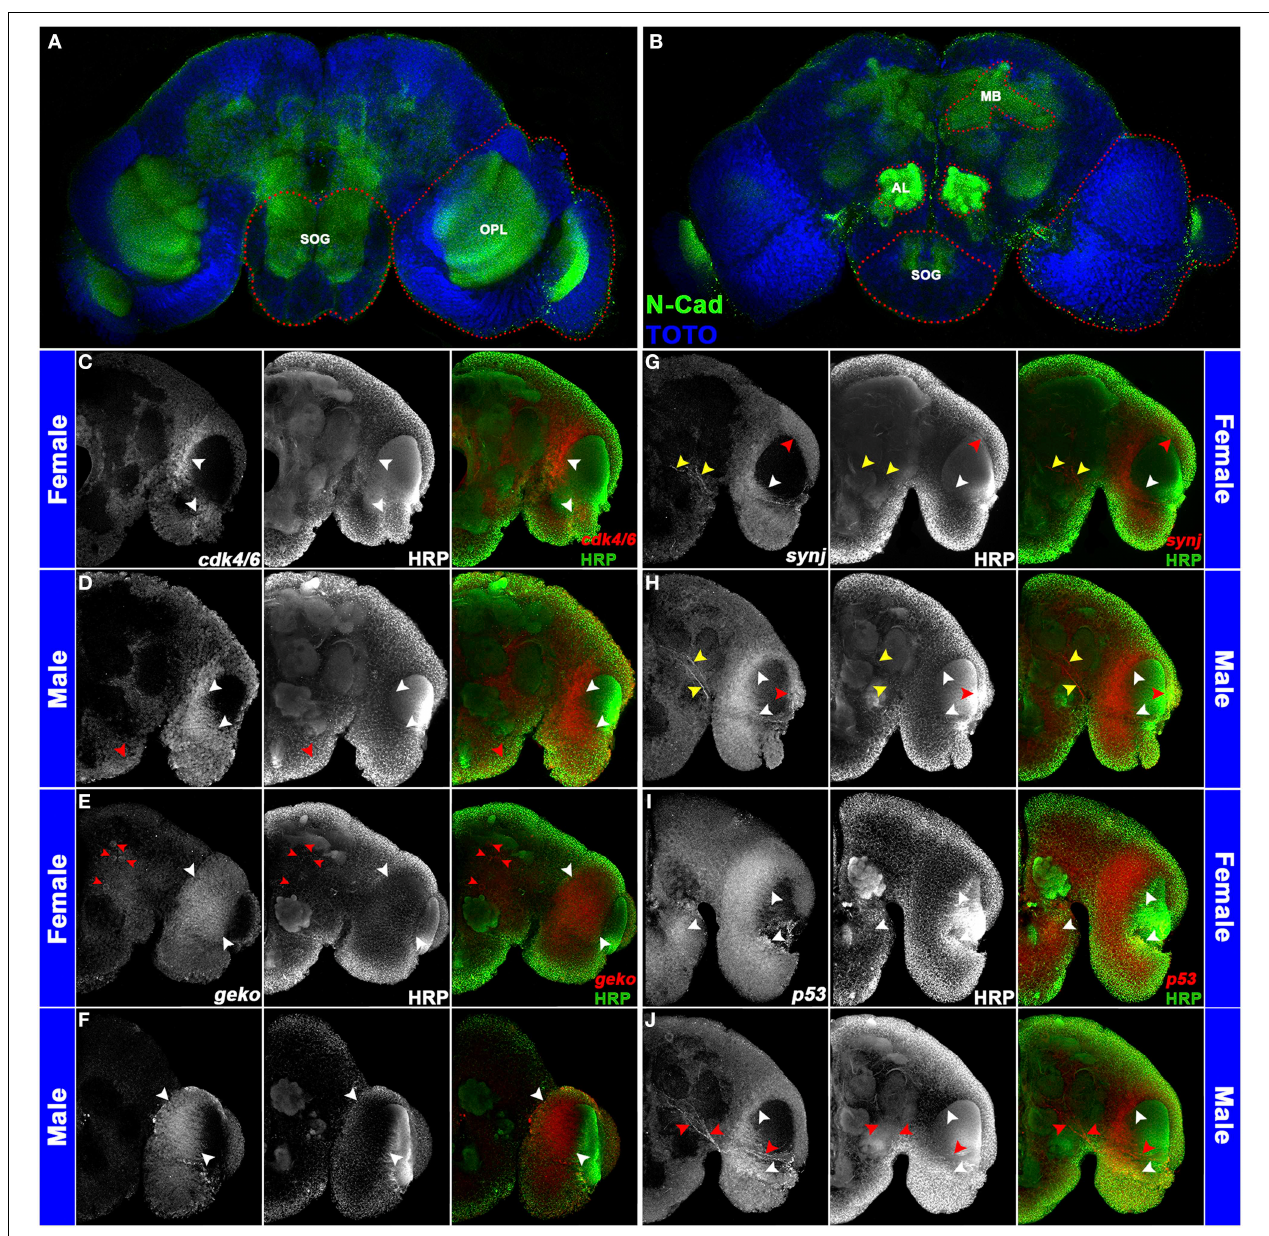
males (red arrowhead in D ). geko , which is expressed in the optic lobe of both sexes (white arrowheads in E,F ), is expressed in additional large cell bodies near the female midbrain and in the female antennal lobe (red arrowheads in E ). Expression of synj is detected in the optic lobe (white/red arrowheads in G,H ) and in a subset of midbrain neurons (yellow arrowheads in G,H ). Sex-specific synj expression is detected in the optic lobe (red arrowheads in G,H ), and midbrain levels of synj are generally higher in males (compare expression adjacent to yellow arrowheads in G,H ). p53 expression is detected in the suboesophageal ganglion and optic lobe of females (white arrowheads in I ). p53 expression is also detected in the male optic lobe (white arrowheads in J ), but not in the subesophageal ganglion of males. Male-specific p53 -expressing neurons are found adjacent to the antennal lobe (red arrowheads in J ). This figure originally appeared in Tomchaney et al. (2014), which contains further information regarding experimental